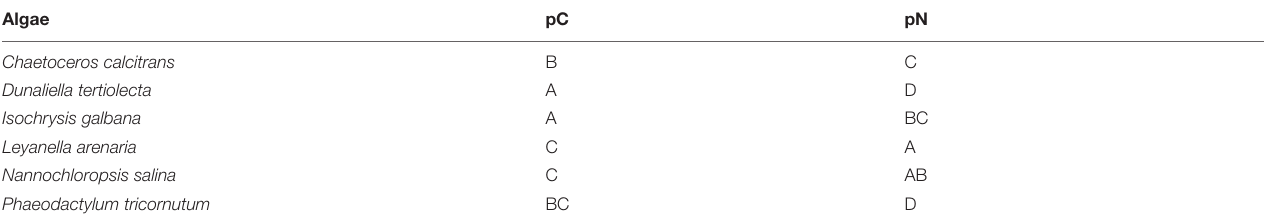
TABLE A1 | Statistical evaluation (algae classified based on multiple range test—Tukey HSD test) of the feeding preference for different dried algal species. Algae pC pN